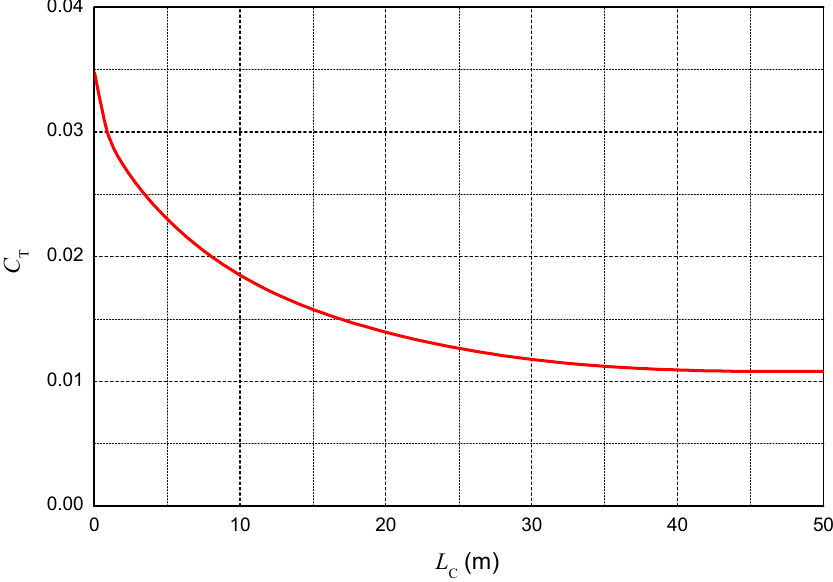
Figure 4. C T values as function of the length L c of the LV unshielded circuits.